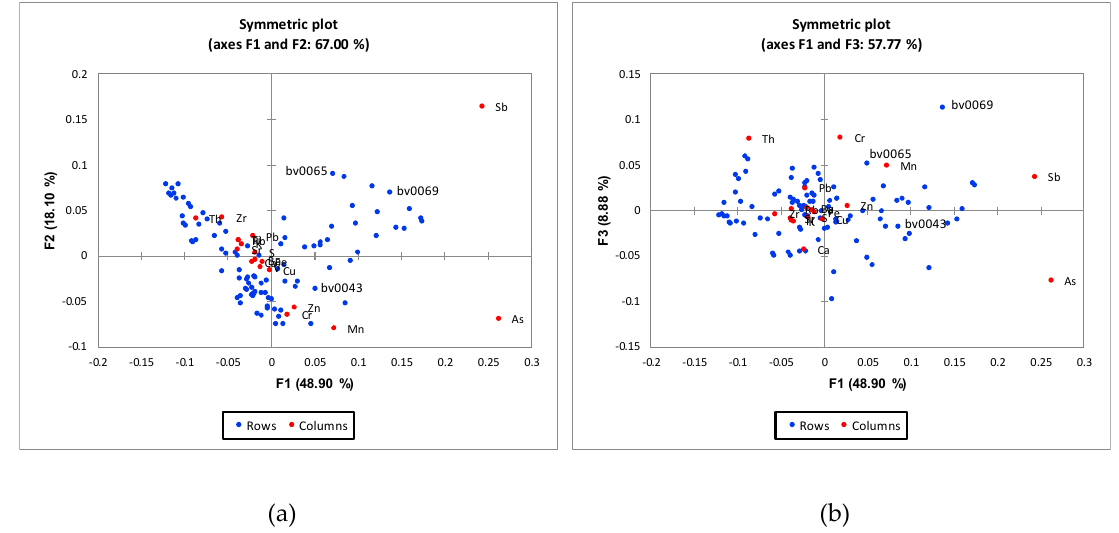
Figure 7. CA symmetric plots for F1-F2 ( a ) and F1-F3 ( b ). Samples from B horizon, pXRF clr data.